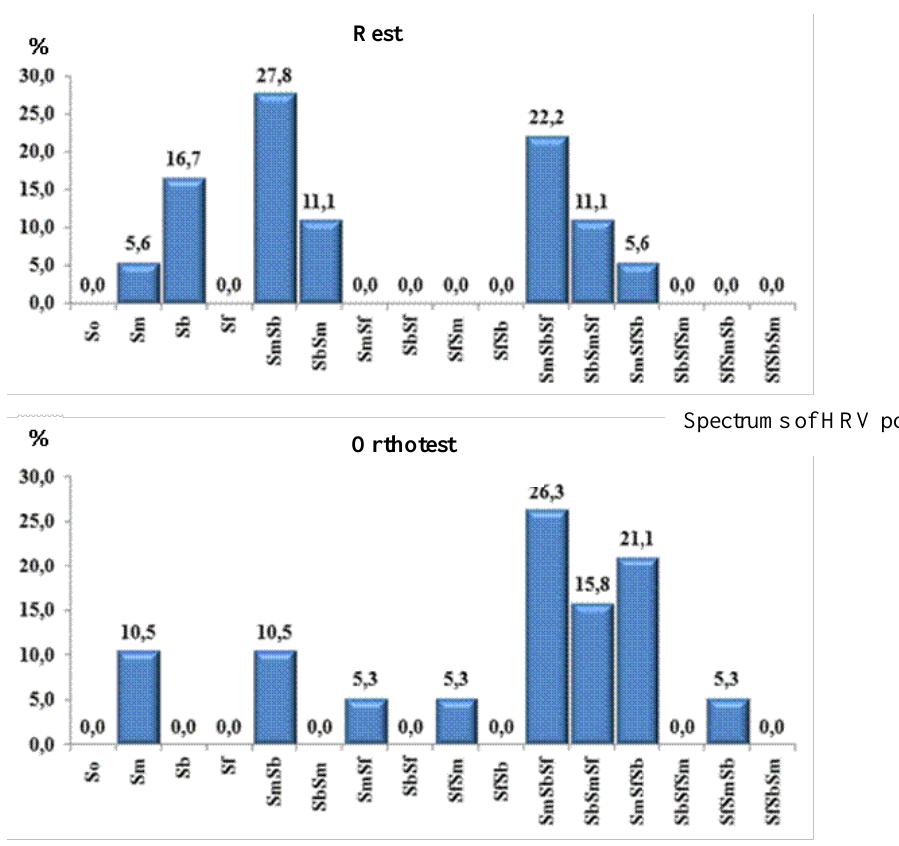
Fig.3. Distribution of types of power spectrums of HRV in rest and after functional loads (AFL) of sportsmen with CT symptoms. Legend on axis X and axis Y is the same as in fig.